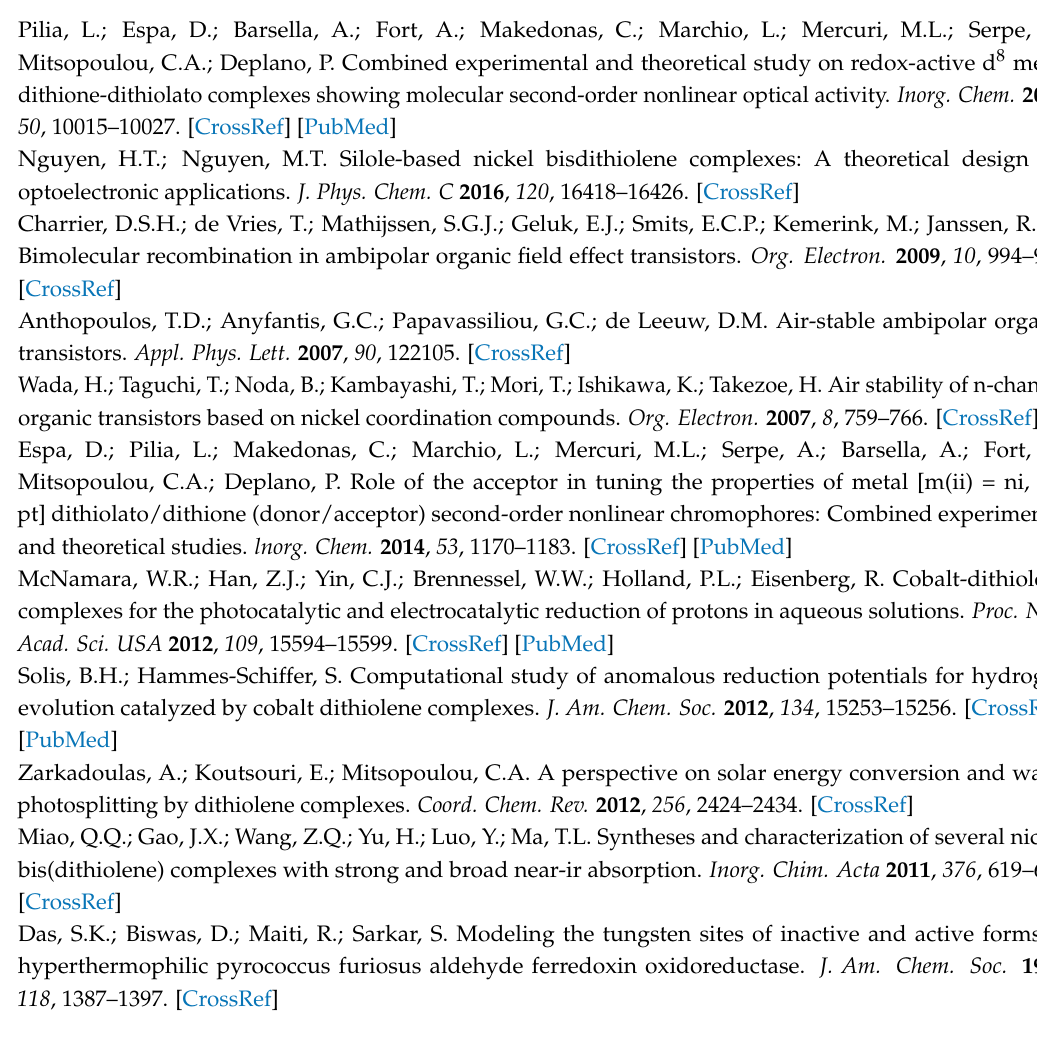
Figure S1: Chemical structure of substituted nickel dithiolenes (R=–CN, –H, –CH 3 ); Table S1: The bond lengths (Å) and bond angles ( ◦ ) of Ni(S 2 C 2 R 2 ) 2 . (R = –CN, –H, –CH 3 ) using different functionals (the available experimental data is in italics), Table S2: The maximum absorption wavelength (cm − 1 ) of Ni(S 2 C 2 H 2 ) 2 in hexane (the available experimental data is in italics), Table S3: The frontier molecular orbitals of Ni(S 2 C 2 R 2 ) 2 optimized by Gaussian 09 software. (R = –NO 2 , –CN, –CF 3 , –F, –H, –CH 3 , –C 2 –H 5 , –CH=CH 2 , –C ≡ CH, –OH, –NH 2 ). Author Contributions: S.H. and Z.K. designed the project; L.S., S.S., Y.L., Y.Z. performed the calculations and wrote the